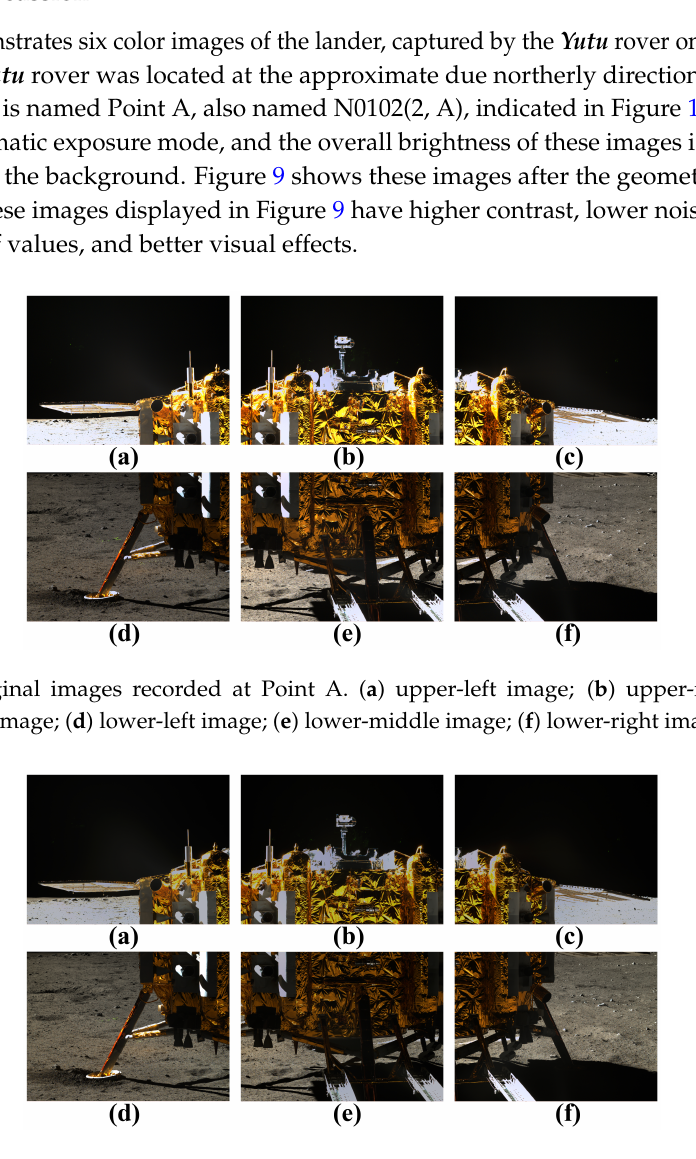
Figure 9. Images after the geometric correction and pre-processing. ( a ) upper-left image; ( b ) upper-middle image; ( c ) upper-right image; ( d ) lower-left image; ( e ) lower-middle image; ( f ) lower-right